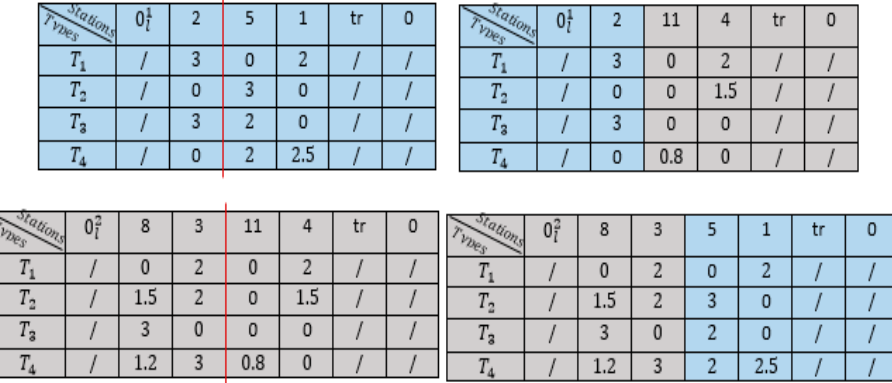
Figure 10. Example to build the second phase in the crossover procedure.